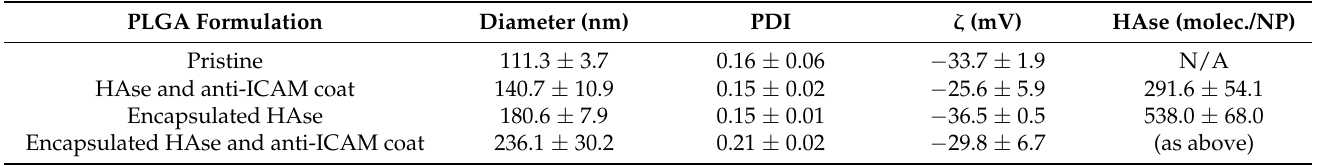
Table 4. Characterization of PLGA NPs with vs. without enzyme cargo and targeting antibody.